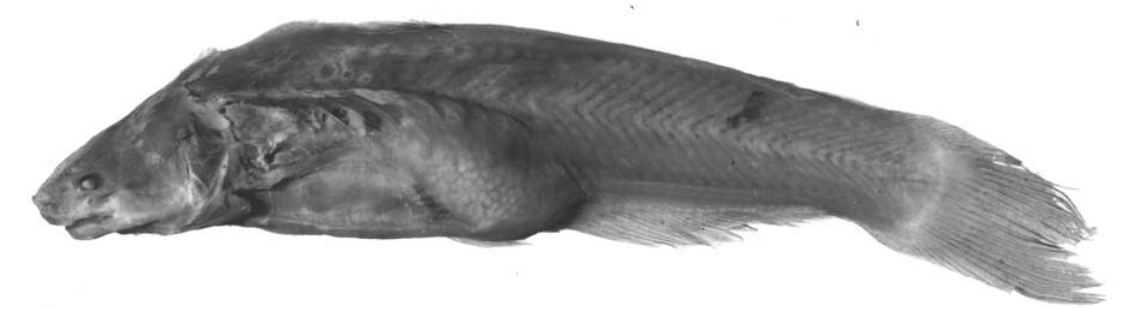
Fig. 23 . Cetopsis jurubidae , holotype of Pseudocetopsis jurubidae , ANSP 71430, mature female, approximately 90 mm SL; Colombia, Chocó, río Jurubidá, Nuquí (5°42’N, 77°17’W).